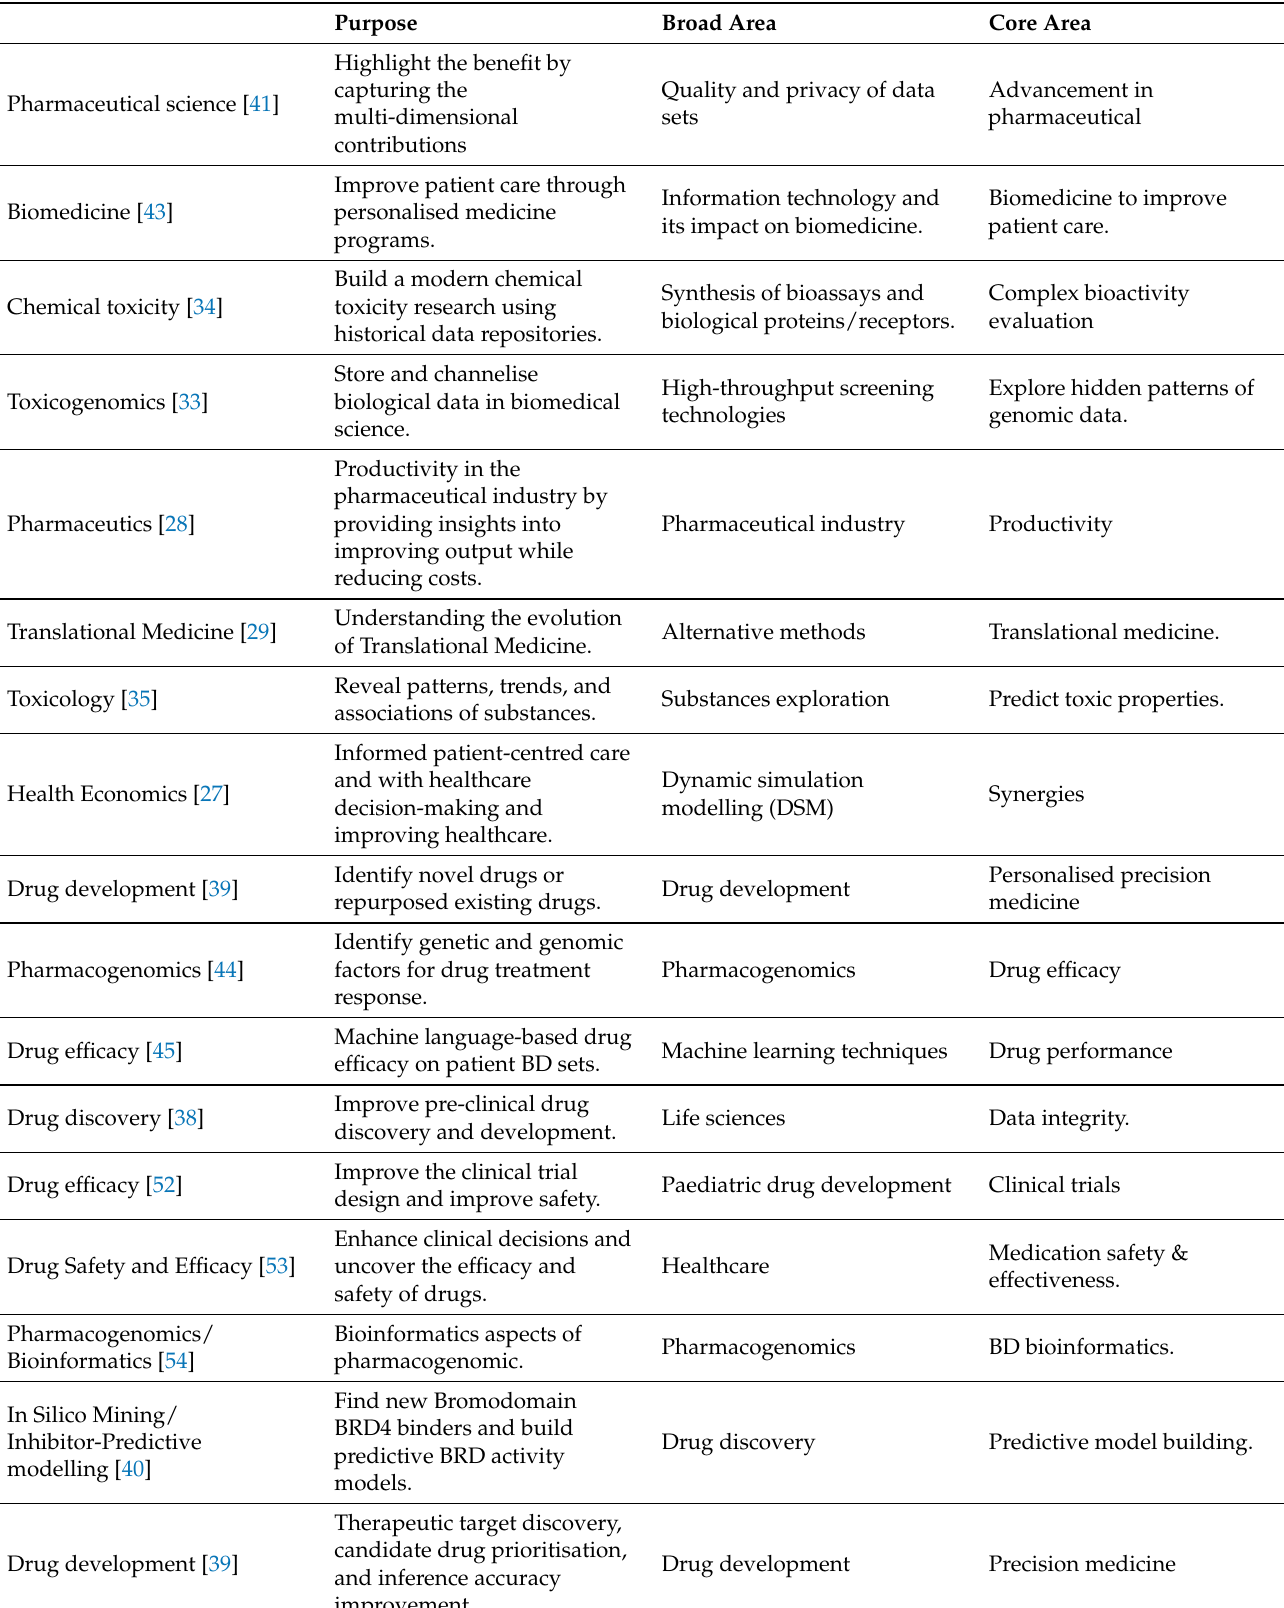
Table 1. Summary of BD in Pharmacology, Toxicology and